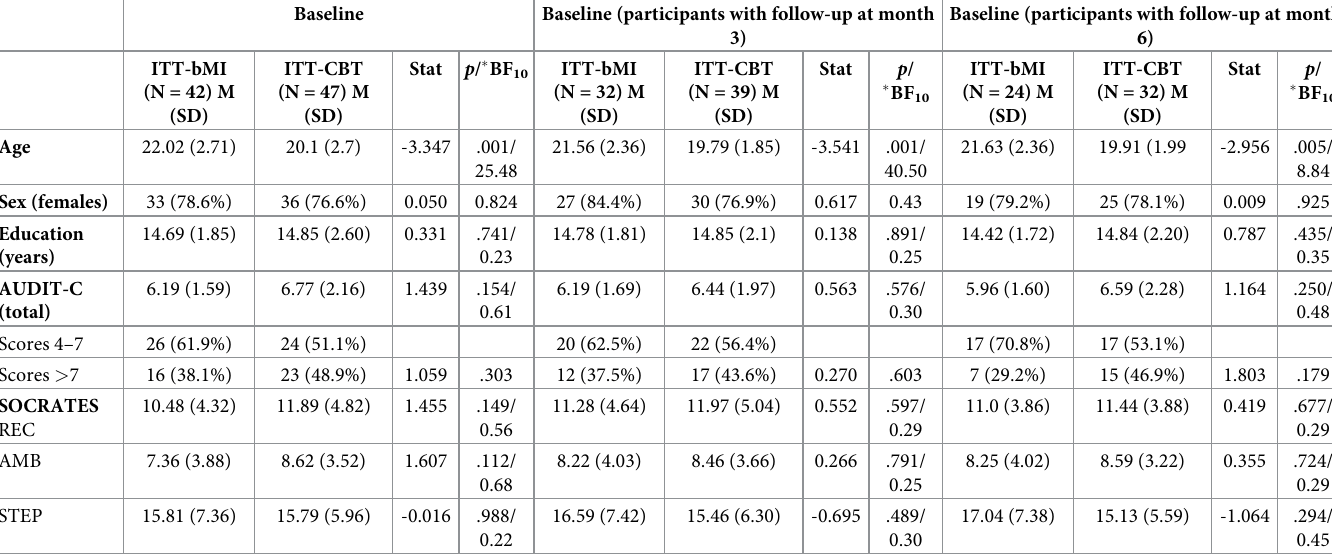
Table 1. Demographics and clinical characteristics of the study groups. Baseline Baseline (participants with follow-up at month